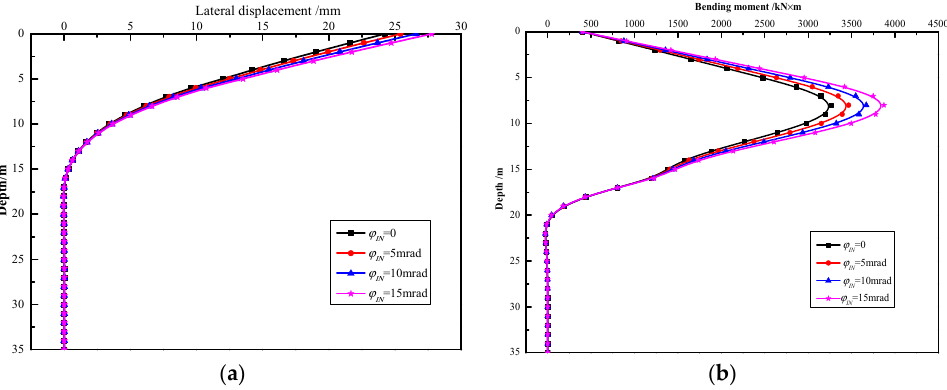
Figure 13. Influence of initial angle of pile on pile lateral behavior. ( a ) Lateral displacement/mm; ( b ) bending moment/kN × m.